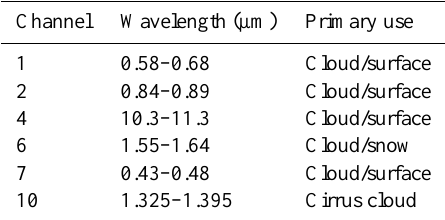
Table 1. FY-3A/VIRR Channels used for the cloud detection algo- rithm in this